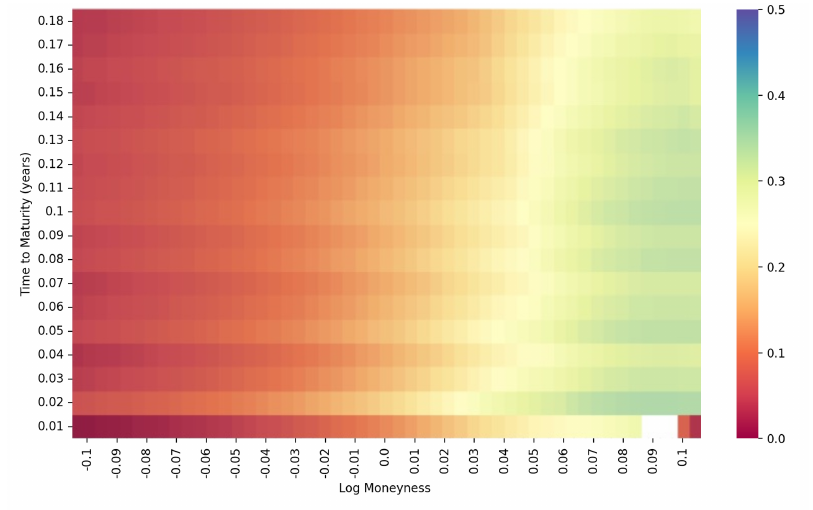
Figure 8. Heatmap of the S&P 500 data under the Heston model.